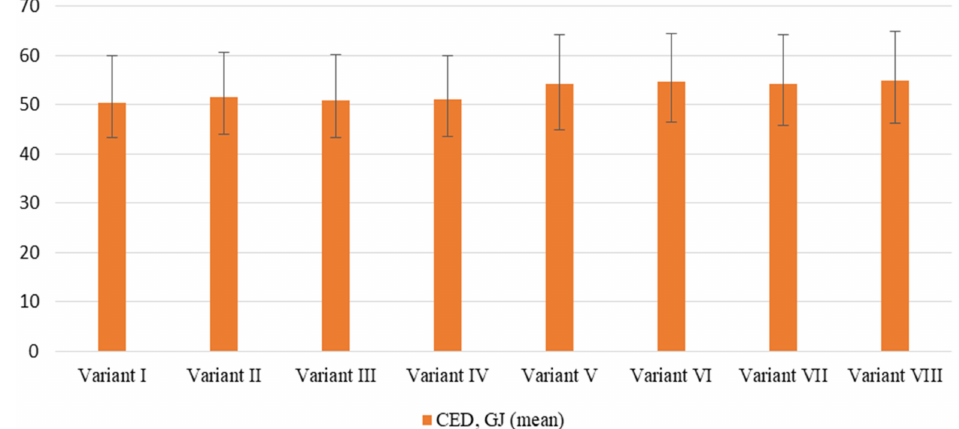
Figure 3. Results of CED calculation with the statistical error based on the Monte Carlo analysis.